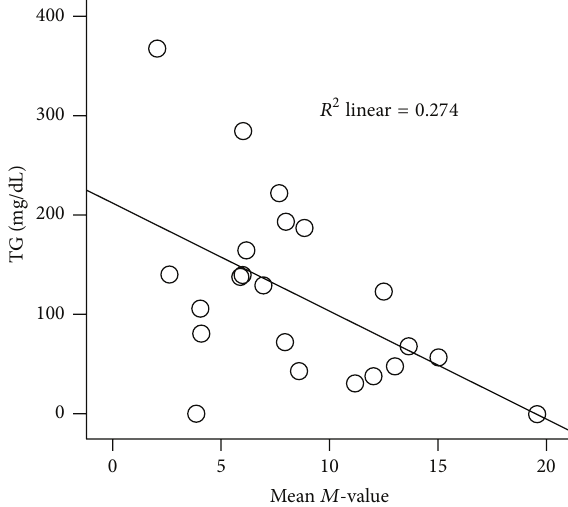
Figure 6: Correlation of triglycerides and mean 𝑀 -values. Triglyc- eride levels negatively correlated with 𝑀 -values.